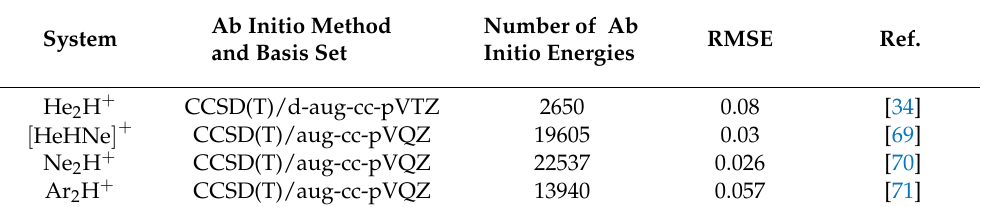
Table 1. Details of methods and basis sets used in the electronic structure calculations, number of ab initio energies used in the fitting, and root mean square errors (RMSE) of the fitting in kcal/mol. Ab Initio Method Number of Ab RMSE Ref. System and Basis Set Initio Energies He 2 H + CCSD(T)/d-aug-cc-pVTZ 2650 0.08 [34] [ HeHNe ] + CCSD(T)/aug-cc-pVQZ 19605 0.03 Ne 2 H +